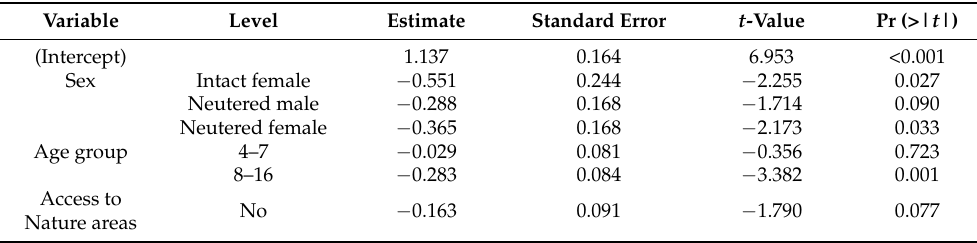
Table 5. Final model for home range including variables Sex (sum of squares = 0.68), Age group (sum of squares = 1.40) and Access to Nature areas (sum of squares = 0.32). The estimates are given in log scale. The residual standard error of the model was 0.317, and the adjusted R-squared was 0.225. In comparison, the full model including all variables had a residual standard error of 0.317 and the adjusted R-squared was 0.226. The reference category (intercept) consisted of intact male cats in the age group 1–3 years with access to nature areas. Variable Level Estimate Standard Error t -Value Pr (>| t |) (Intercept) 1.137 0.164 6.953 <0.001 Sex Intact female − 0.551 0.244 − 2.255 0.027 Neutered male − 0.288 0.168 − 1.714 0.090 Neutered female − 0.365 − 0.029 −